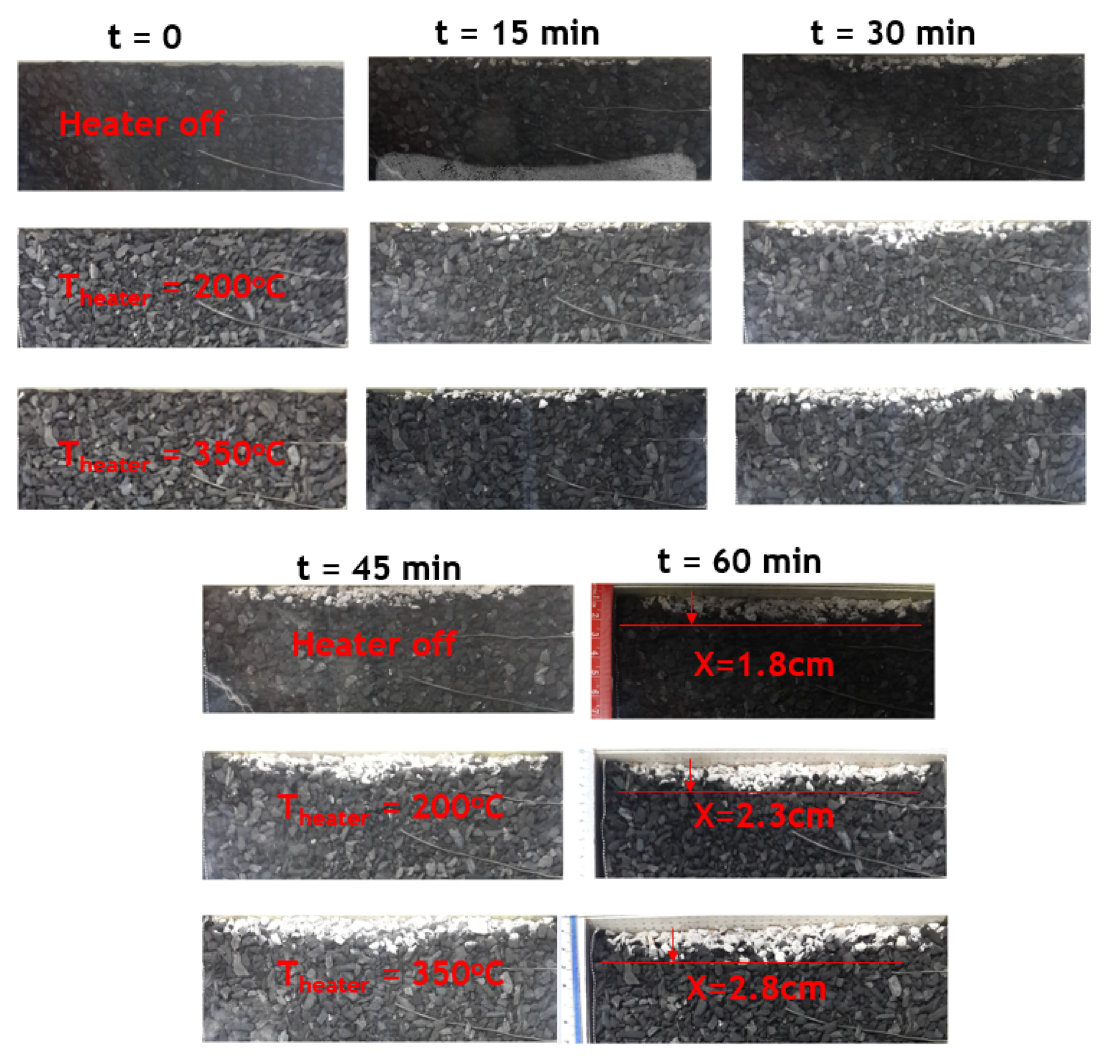
Fig. 13 Reaction propagation of surface coal packed bed for coal